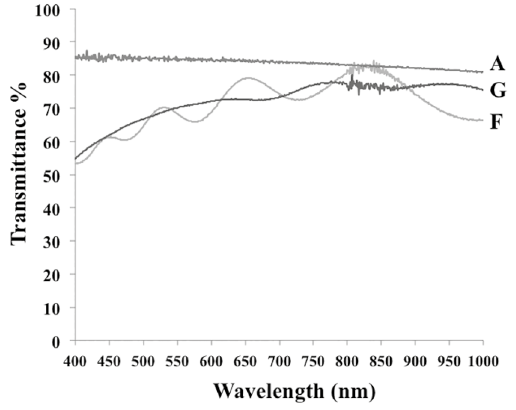
Figure 4: Transmittance spectra obtained of the A, G and F